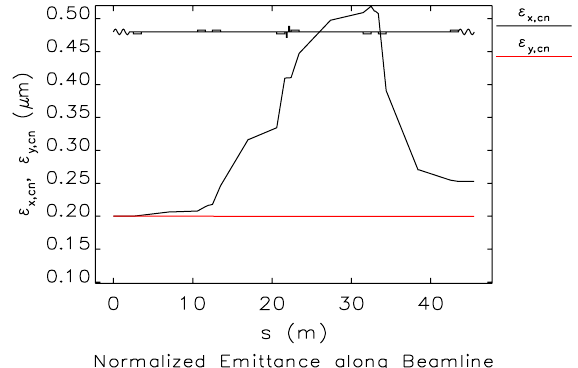
FIG. 9. The emittance growth in the first chicane is largely compensated in the second chicane with careful tuning of all parameters.